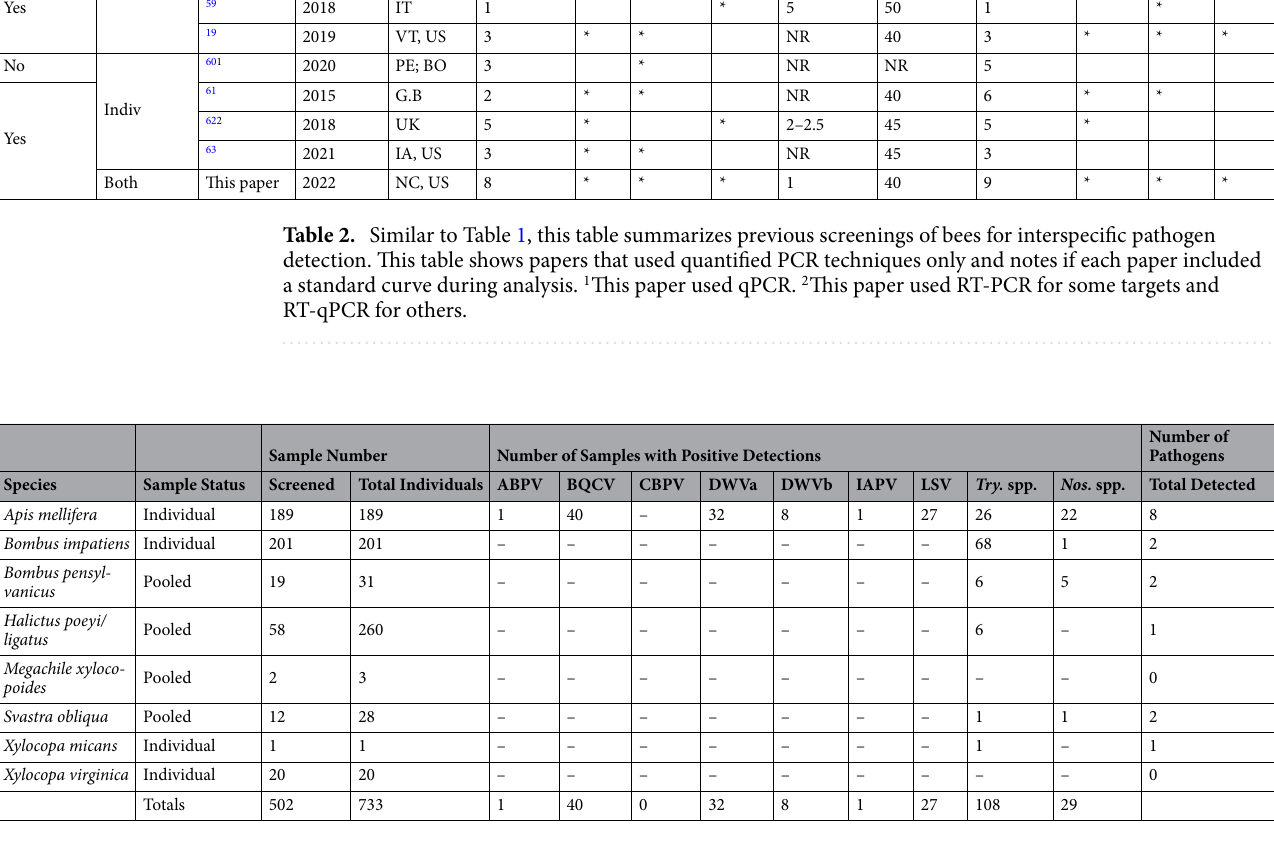
Table 3. A summary of the number of individuals and pools screened for each bee species during pathogen analysis. The number of samples screened, total number of samples included, number of positive detections for each pathogen, and total number of pathogens detected are